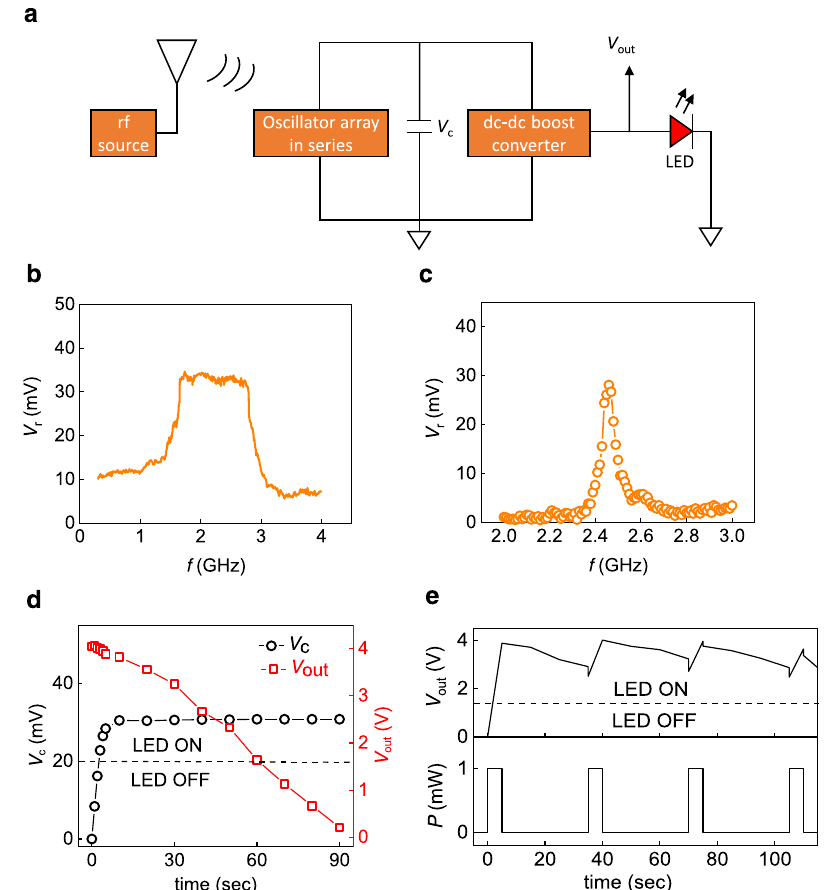
Fig. 6 Demonstration of energy harvesting of wireless radio frequency power. a Schematic of the circuit used for the energy harvesting. The wireless signal from the horn antenna or microstrip patch-antenna with a power of 0 dBm is irradiated on the array of eight electrically connected STOs in series at zero magnetic fi eld and dc bias. The recti fi ed signal is stored in the capacitor, which is then supplied to the dc – dc boost converter for supplying the voltage to power the red LED. b Recti fi ed response of eight oscillators in series when irradiated by a horn antenna fed by a signal generator with the gain of 6 – 7 dBi in the range of 1 – 4 GHz. c Recti fi ed response of the eight STOs connected in series at rf power of 0 dBm from the patch antenna at zero magnetic fi eld and dc bias. d Charging voltage ( V c ) of the capacitor from the eight STOs recti fi ed output with time on the left axis. The right axis shows the dc – dc converter output ( V out ) when the wireless output is off. e The output voltage from the dc – dc boost converter in response to the power of 0 dBm (1 mW) applied from the signal generator to the patch antenna with on and off time of 5 and 30 s,